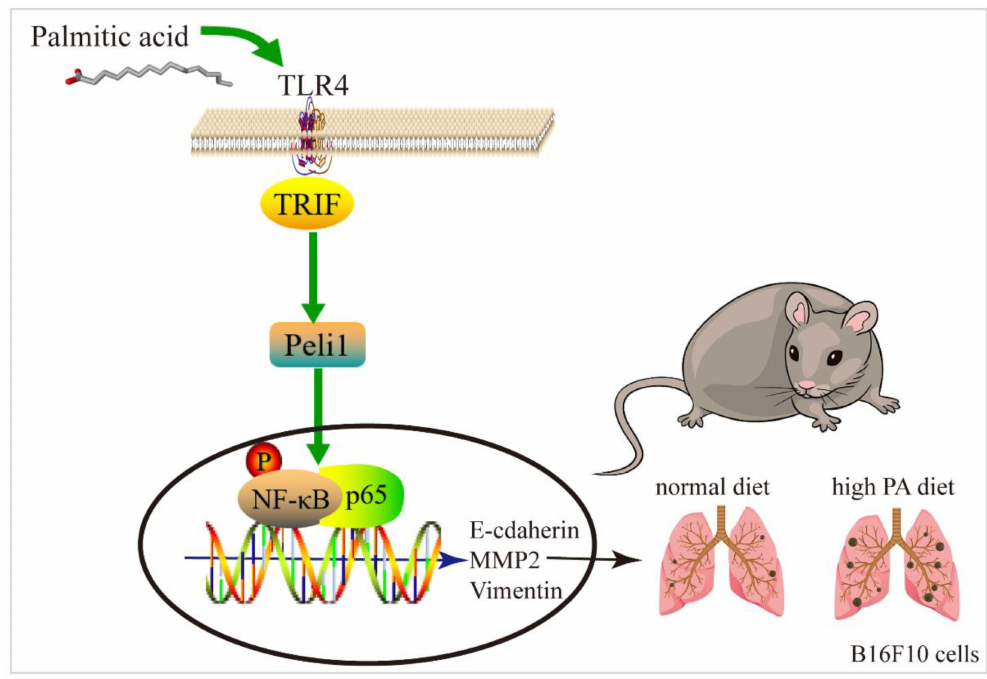
Figure 8. Mechanism simulation diagram of melanoma lung metastasis. Supplementary Materials: The following supporting information can be downloaded at: https://www. mdpi.com/article/10.3390/metabo12111132/s1, Figure S1: Serum cholesterol level; Figure S2: Identi- fication of siRNA interference efficiency. (A) Interference efficiency of siRNA in B16. (B) Interference efficiency of siRNA in